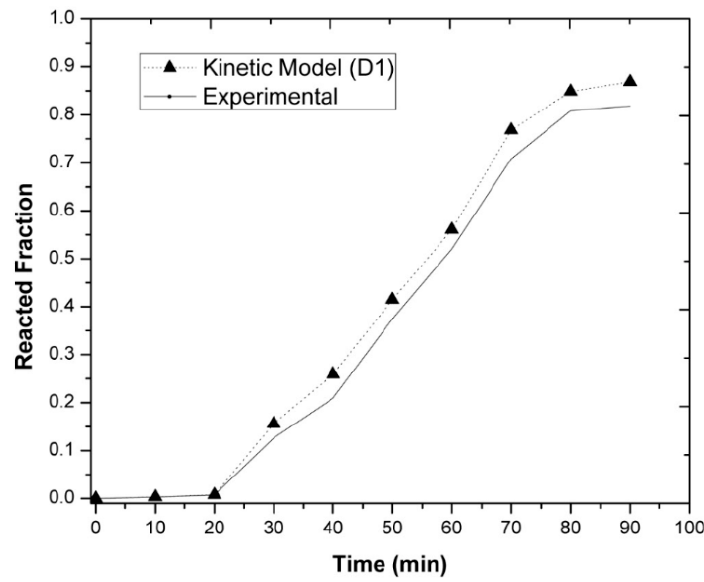
Figure 15. Experimental results and prediction of model D1 at the temperature of 1123 K for an alloy with 3 wt-% Mg at 300 rpm.